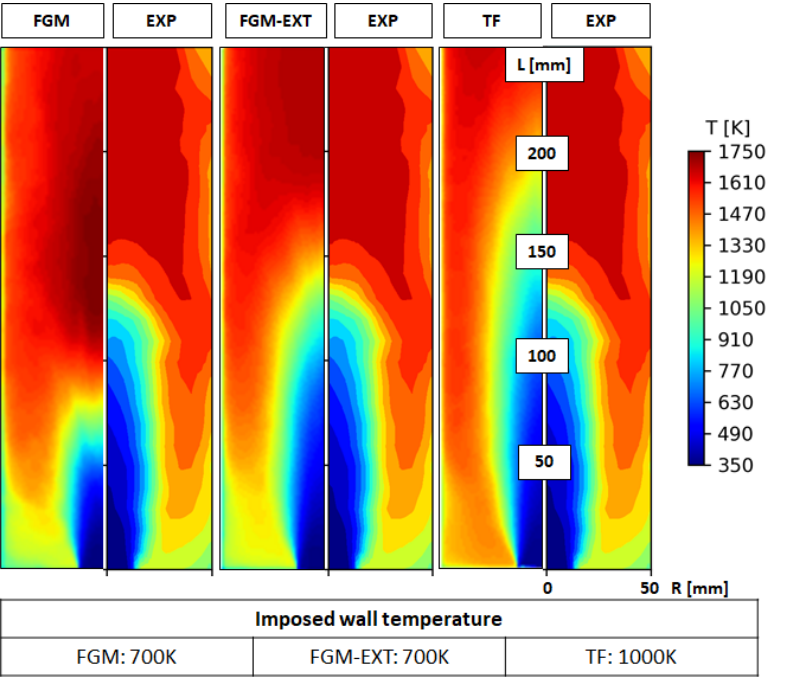
Figure 11. Contour maps of averaged temperature, respectively, for (from left to right ) FGM, FGM- EXT, TF combustion models, and experimental data from